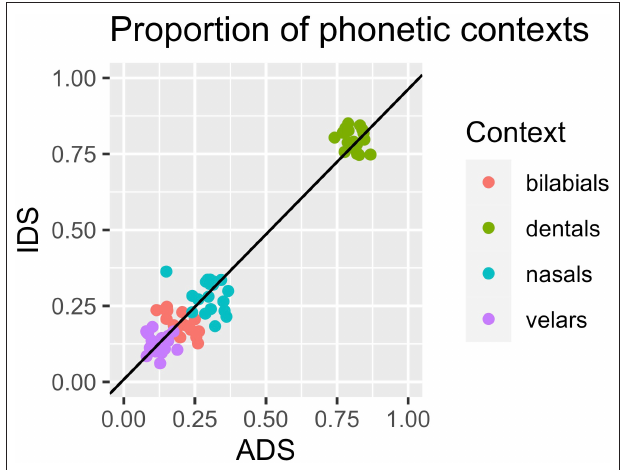
FIGURE 5 | Proportion of vowel tokens with context consisting of a bilabial (red), a dental/alveolar (green), a velar (purple), or a nasal (blue). Proportions are calculated per participant, in ADS (x-axis) and IDS (y-axis) separately.